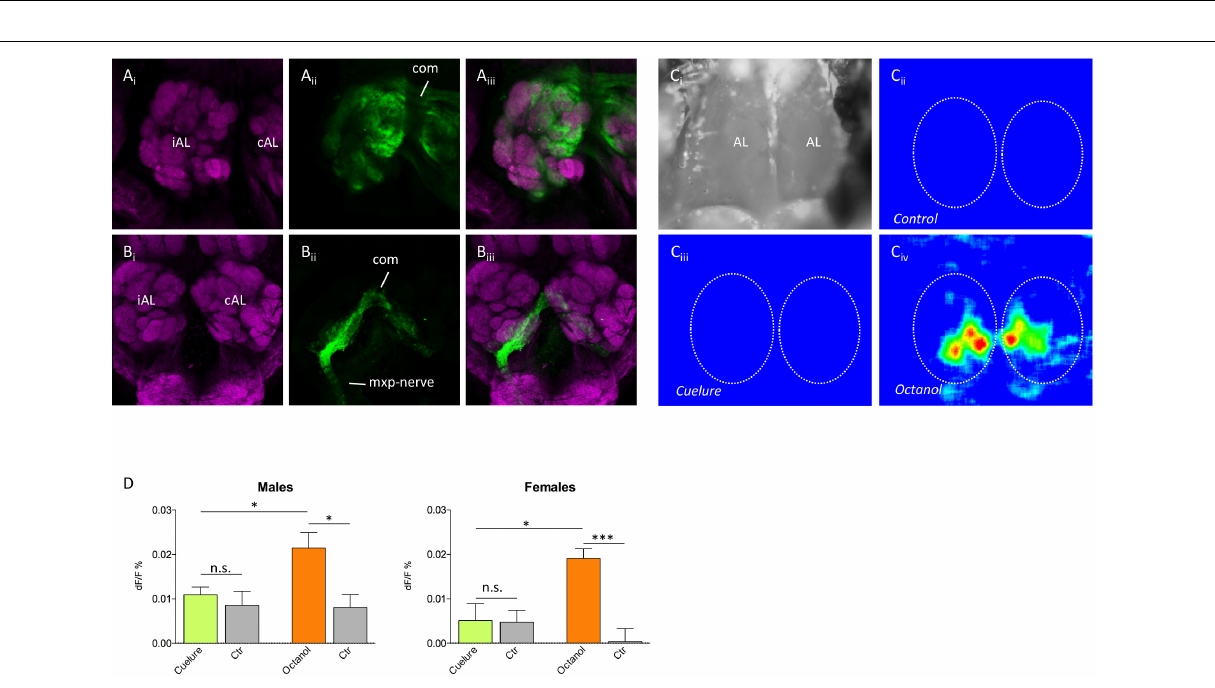
Frontiers in Physiology |